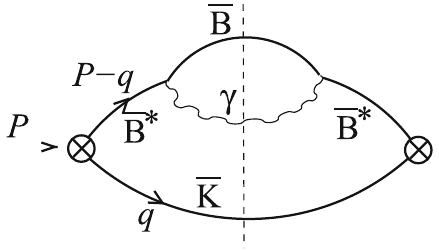
Fig. 4 ¯ B ∗ ¯ K loop considering the B ∗ → B γ decay. The cut shown is the source of the imaginary part of the unitarized ¯ B ∗ ¯ K scattering amplitude